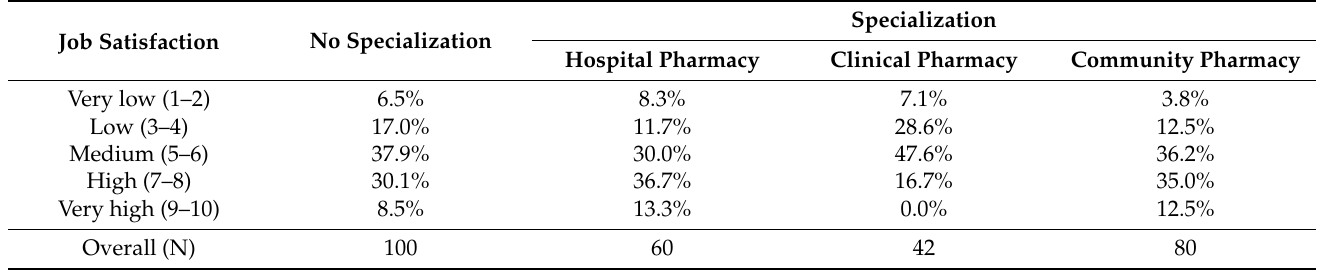
Table 2. Satisfaction with the current way of practicing the profession of pharmacist and